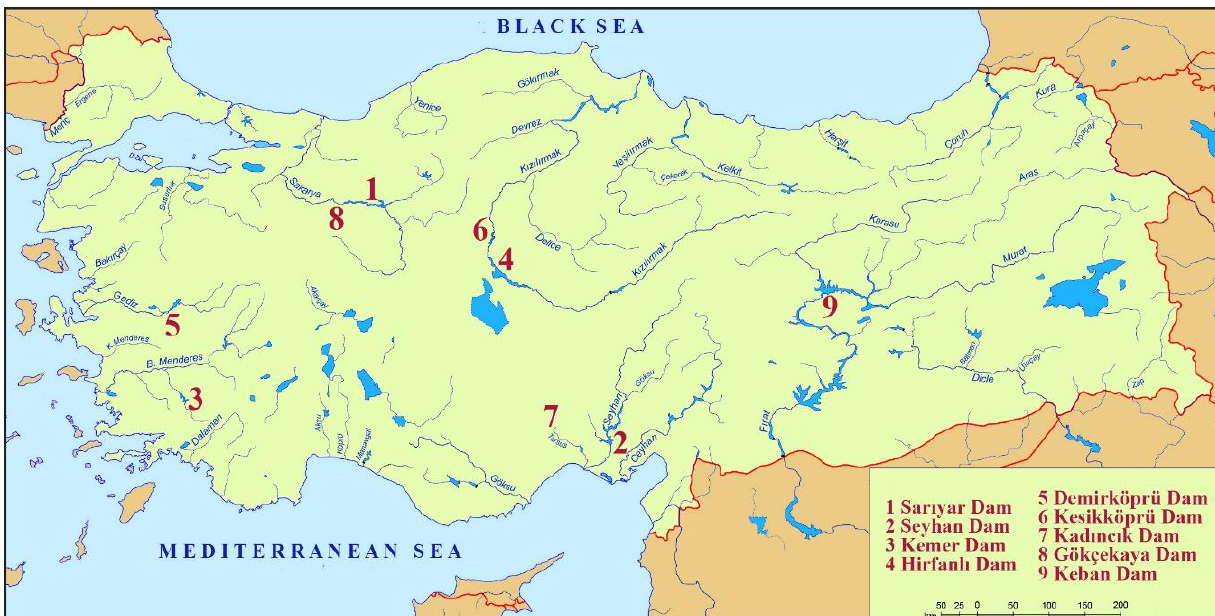
Figure 9. Map of hydroelectric plants (with the installed capacity over 50 MW) constructed before 1975 in Turkey.